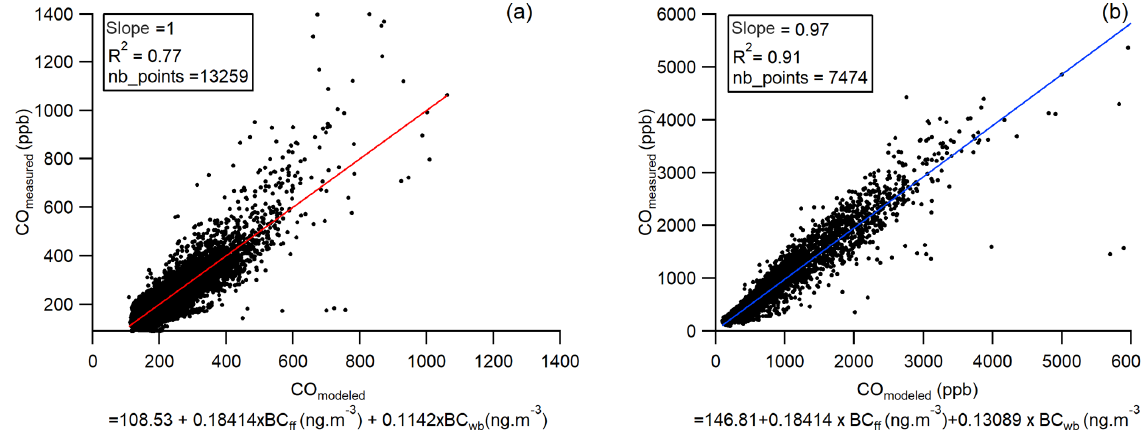
Figure 8. Best-fit linear correlations between CO and a combination of BC ff and BC wb for DEM (a) and NOA station (b) .